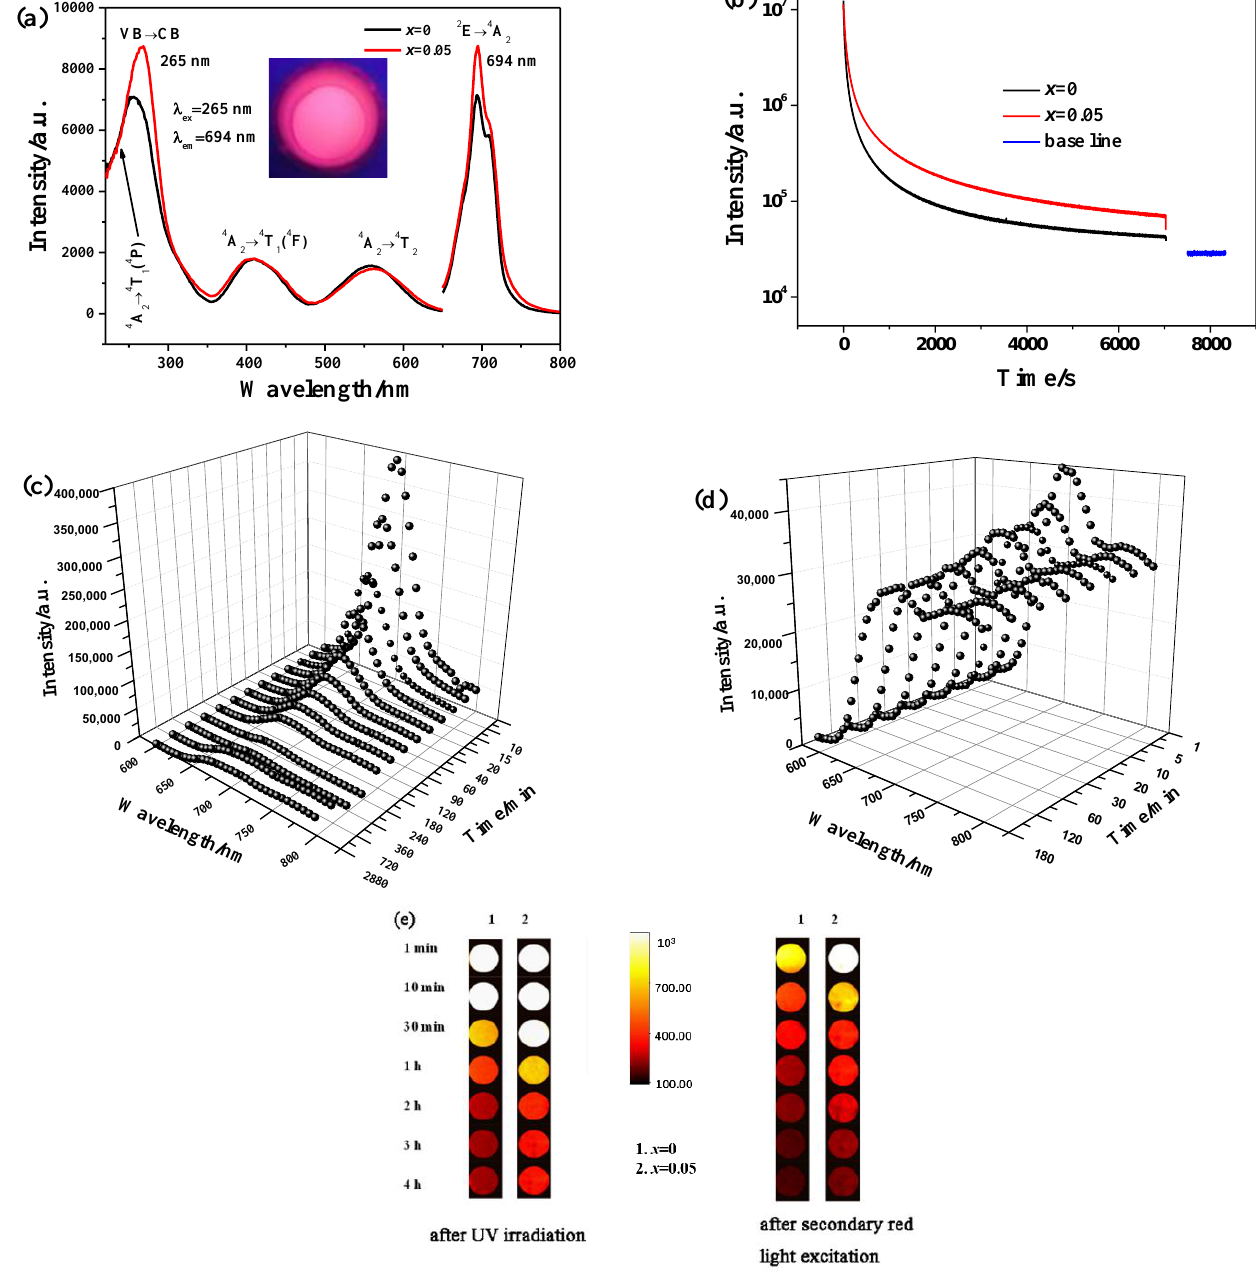
Figure 6. ( a ) PLE/PL spectra and ( b ) NIR persistent luminescence decay curves (monitored at 694 nm, 5-min excitation at 254-nm UV light illumination) of x = 0 and x = 0.05 samples. ( c , d ) are persistent luminescence spectra of x = 0.05 sample with various durations after stopping UV light and secondary excitation with a red light from a LED lamp. ( e ) is appearance of NIR afterglow of x = 0.05 sample with various durations obtained by a Kodak In Vivo Imaging System FX Pro at different times after removing UV irradiation for 5 min and the appearance of recharging NIR afterglow thought a secondary excitation of red